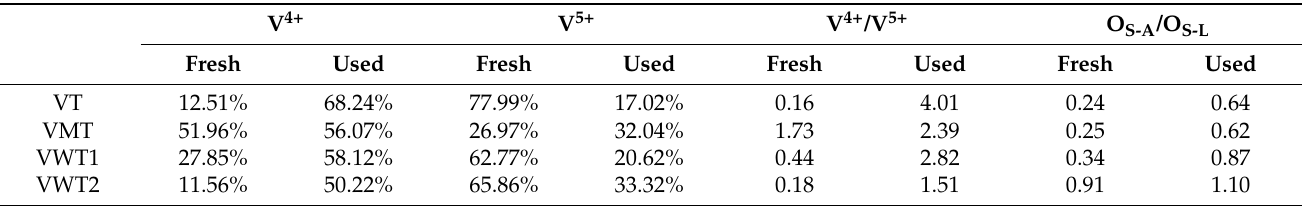
Figure 4. ( a ) The valence distribution of vanadium in fresh catalysts, ( b ) in used catalysts; ( c ) the distribution of oxygen species in fresh catalysts, ( d ) in used catalysts. Table 3. The chemical states of vanadium and oxygen of fresh/used catalyst.